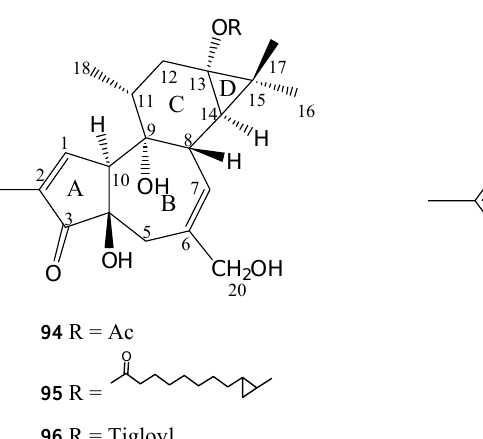
Figure 3. Tigliane diterpenoids isolated from Euphorbia